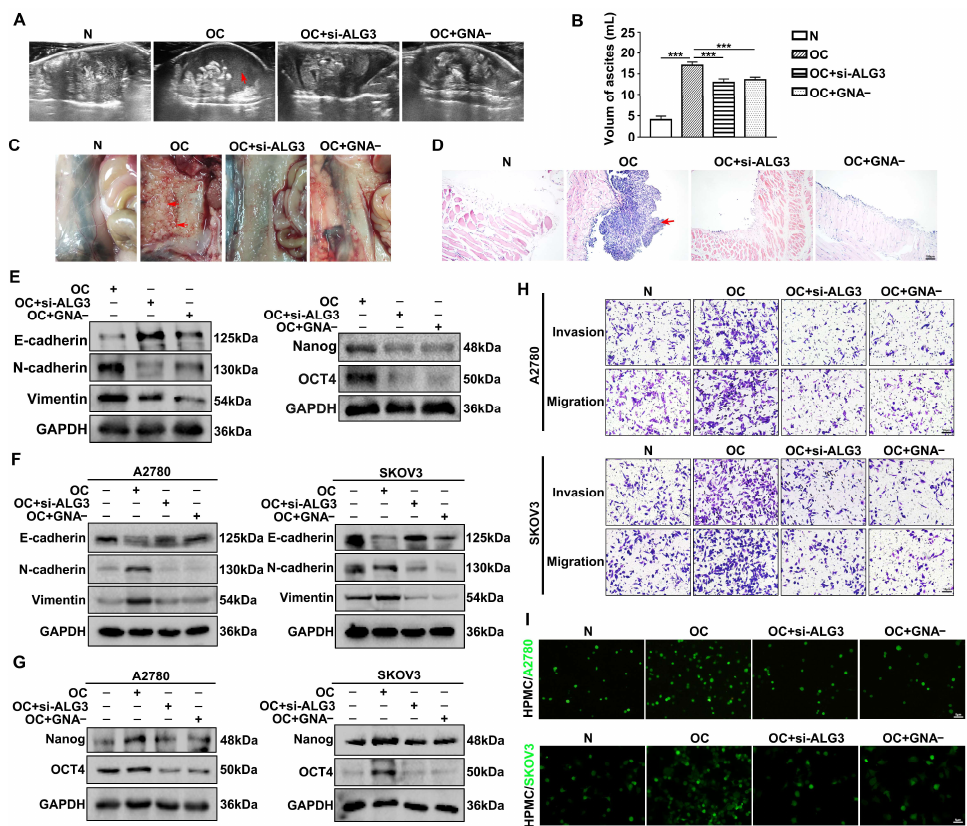
Figure 7. Downregulation of α1,3-mannosylation inhibits tumor peritoneal metastasis in a mouse model. ( A ) Ultrasound image to detect the amount of ascites (red arrow) in the peritoneal cavity of different groups (OC, si-ALG3 and GNA-). ( B ) Statistical analysis of the volume of ascites among the groups before mice were sacrificed. ( C ) Representative images of the cancer metastasis nodes (red arrows) in the peritoneum. ( D ) The HE-stained peritoneum was dissected longitudinally. The red arrow indicates metastatic tumor nodes. ( E ) Western blot analysis of EMT and stemness marker expression in peritoneal cancer tissues. ( F , G ) Western blots showing the expression of EMT and stemness markers in A2780 and SKOV3 cells treated with ascites from the mouse peritoneal cavity. ( H ) The migration and invasion potential detected by transwell migration/Matrigel invasion assay.